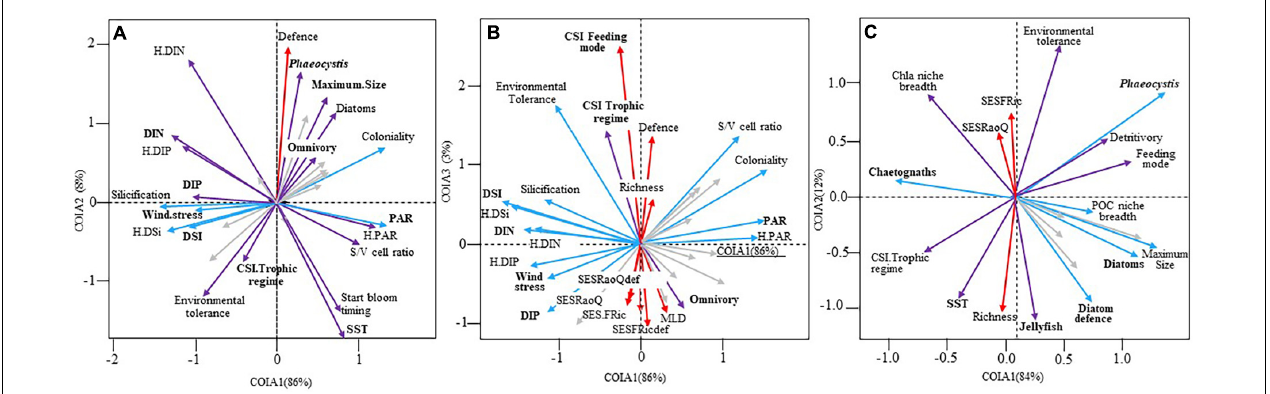
FIGURE 6 | Projection of the environmental variables, species richness, functional structure, ecological specialization and functional diversity of (A,B) diatoms ( N = 63, RV = 0.49, p = 10 − 3 ) and (C) copepods ( N = 63, RV = 0.36, p = 10 − 3 ) on the factorial maps ( A: 1–2, B: 1–3 and C: 1–2) of the co-inertia analysis performed on the diatom and copepod community in coastal waters of the eastern English Channel over the period 2007–2013. Bold labels: “environmental” variables. Only the variables that contribute the most to the construction of the axes are labelled (see Supplementary Table 6 for details). Gray arrows: no or low ( r < 0.5) significant Pearson correlation between the variables and the first (blue arrows), second (red arrows) or both first and second or third (purple arrows) co-inertia axes. PAR, Photosynthetic Active Radiation; DIN, DIP, DSi, Dissolved Inorganic Nitrogen, Phosphorous, and Silica; SST, Sea Surface Temperature; S/V ratio, Surface to Volume cell ratio; MLD, Maximum Linear Dimension; CSI, Community Specialization Index; SES-FRic, the functional richness, SES-RaoQ, the functional divergence; def., defence against